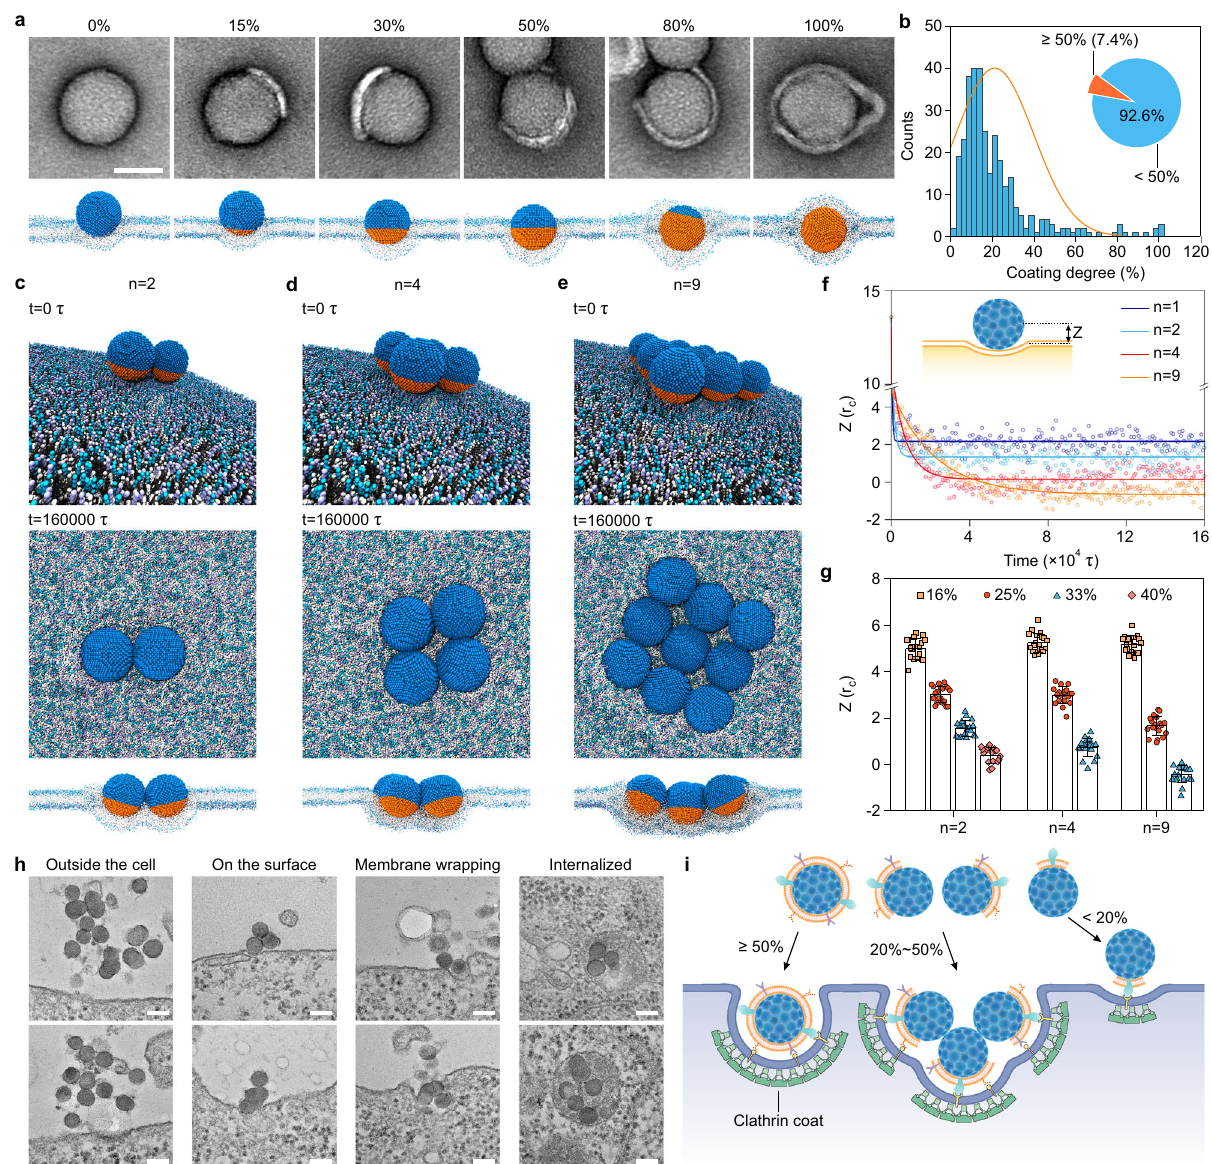
Fig. 4 Endocytic entry mechanism of partially coated NPs. a Top: TEM images of SiO 2 NPs with different cell membrane coating degrees (0%, 15%, 30%, 50%, 80%, and 100%). Scale bar, 50 nm. Bottom: the corresponding fi nal dissipative particle dynamics (DPD) simulation snapshots of the wrapping of the CM-SiO 2 NPs by a modeled cell membrane. It shows that the wrapping of a single CM-SiO 2 NP with a higher coating degree is easier than that of an NP with a lower coating degree. b Cell membrane coating degree distribution of as-prepared CM-SiO 2 NPs, which is calculated from TEM images ( n = 325). The inset shows the proportion of SiO 2 NPs with a low cell membrane coating degree (<50%). c – e Typical DPD simulation snapshots of multiple CM-SiO 2 NPs: aggregation number ( n ) = 2 ( c ), 4 ( d ), and 9 ( e ). The coating degree of each NP is 33%. The top panel ( t = 0 τ ) shows the setup of the simulation system and the other panels ( t = 160,000 τ ) displays the fi nal equilibrated NP-membrane structure at the top view and the pro fi le view. f Time evolution of CM-SiO 2 NPs positions along the membrane normal direction. Z represents the distance between the center of the NP and the cellular phospholipid bilayer (inset). g Comparison of positional change of CM-SiO 2 NPs with different aggregated numbers (2, 4, and 9) and coating degrees (16%, 25%, 33%, and 40%). Data represents mean ± SD ( n = 20). h TEM images showing the different states of CM-SiO 2 NPs during receptor-mediated interactions with CT26 cells. Scale bars, 100 nm. i Schematic illustration of a possible endocytic entry mechanism for partially coated